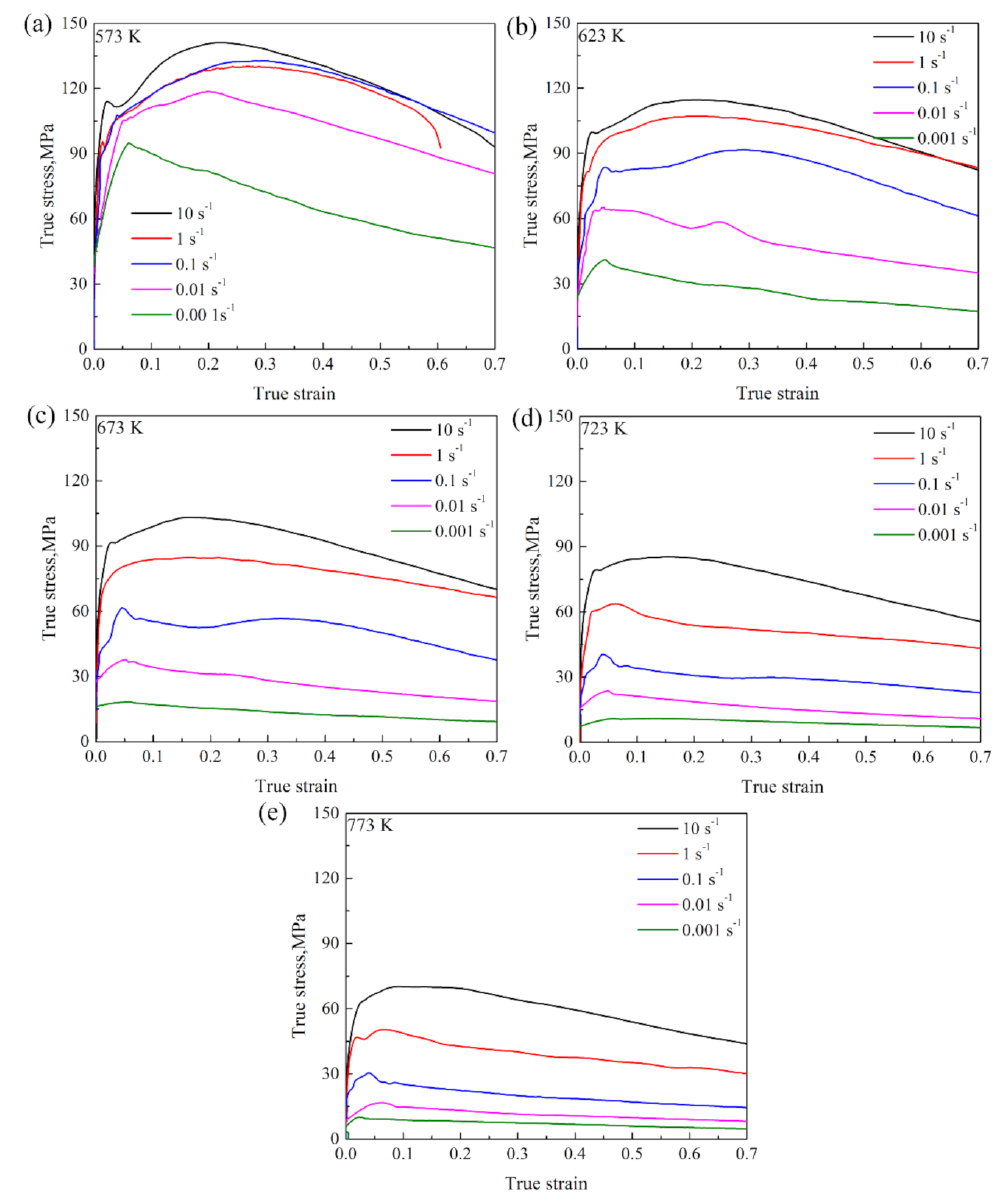
Figure 2. True stress–strain curves of the Mg-2.5Nd-0.5Zn-0.5Zr alloy at various hot deformation temperatures: ( a ) 573 K, ( b ) 623 K, ( c ) 673 K, ( d ) 723 K, ( e ) 773